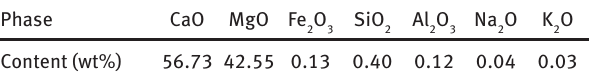
Table 1: Chemical analysis of calcined